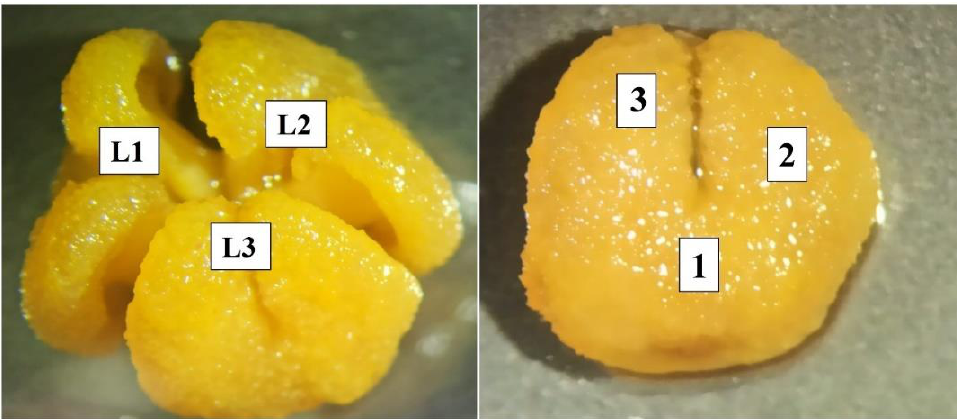
Figure 2. The three stigmatic lobes (L1, L2 and L3) of the watermelon flower (left) and the sampling areas in each lobe (1, 2 and 3 points) of the watermelon flower (right).